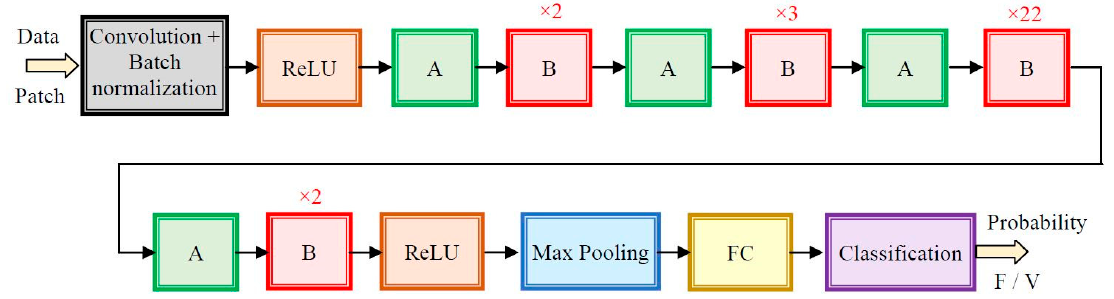
Figure 9. ResNet architecture (A and B—repetitive modules described in Figure 10, FC—fully connected layer, F—flood type patch, V—vegetation type patch, and ×n—number of module repetition).